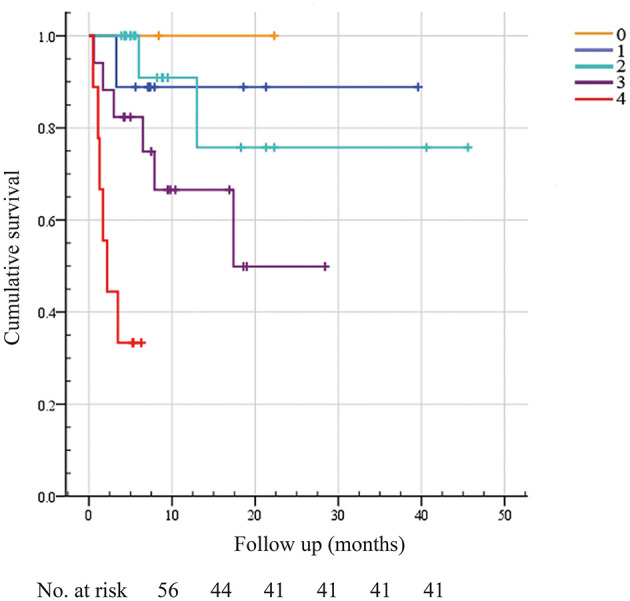
A new scoring system for predicting overall survival incorporating sST2, troponin I, NT-proBNP, and dFLC. A new scoring system including ST2 and other known cardiac risk factors, such as the dFLC and Mayo 2012 staging systems, was built to predict overall survival. We assigned 1 point for sST2 ≥12.34 ng/ml, troponin I >0.025 μg/L, NT-proBNP >1,800 pg/ml, and dFLC >180 mg/L, as reported before. The maximum score was 4, and the minimum score was 0. Score 0, none of the four conditions are met; Score 1, one condition is met; Score 2, two conditions are met; Score 3, three conditions are met; Score 4, all four conditions are met. There were 0 (2), 1 (9), 2 (19), 6 (17), and 6 (9) death events in the 0–4 scoring system, respectively.